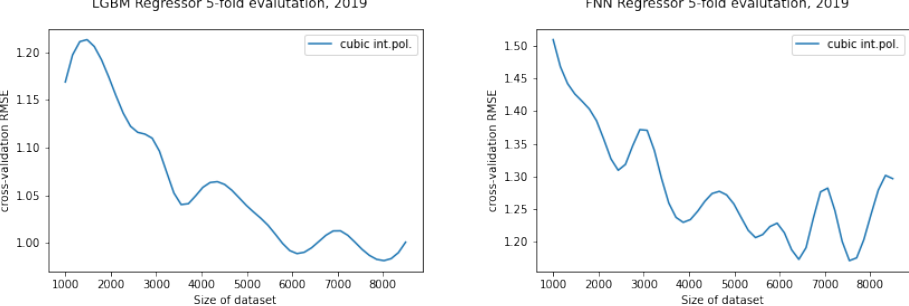
Figure 9. The regression RMSE decreased as the size of the dataset increased, with grid G-50 and input VH-VV from Sentinel-1. This result indicates that the Sentinel-1 data contain valuable information for predicting 2019 yield. Results from LGBM ( left ) and FNN model ( right